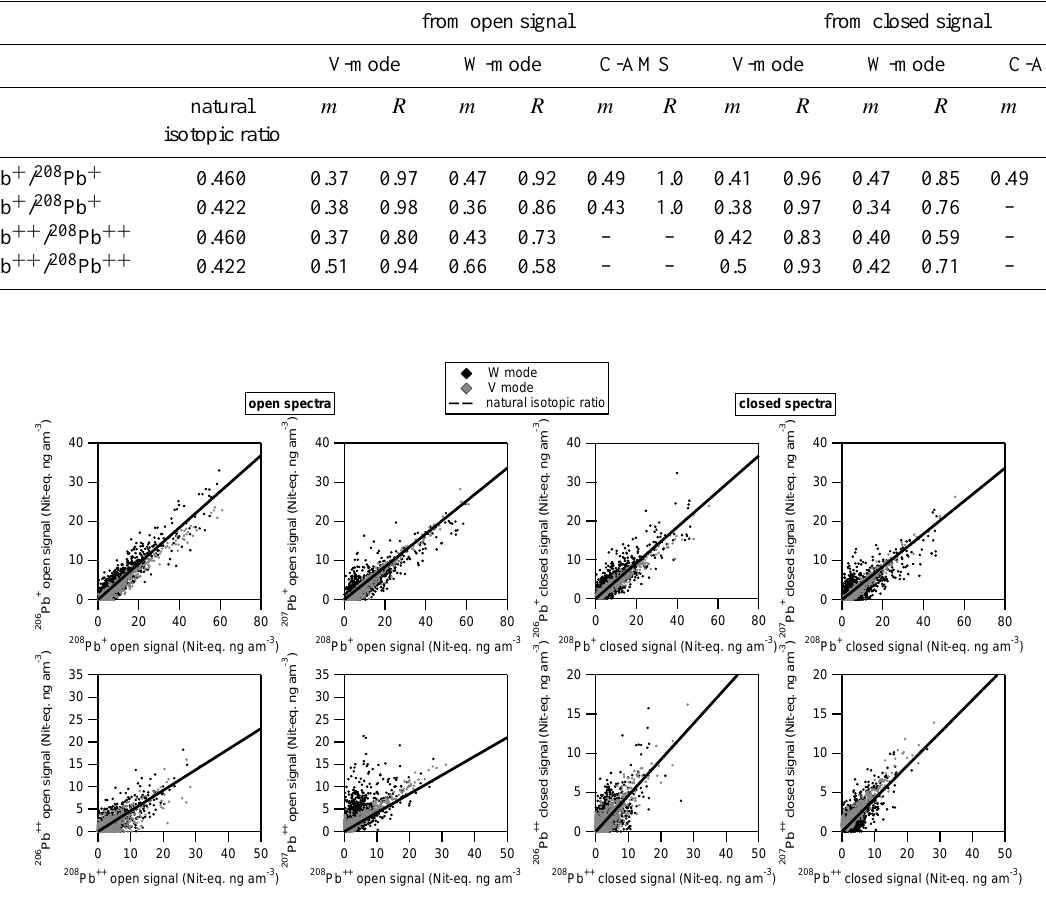
Fig. 3. Scatter plots of lead isotopic ion signals obtained with the HR-AMS located at T0. V and W mode data for open and closed spectra are shown. Black lines correspond to the expected isotopic ratio (deLaeter et al., 2003). The top panels show the singly charged ions and the bottom panels show the doubly charged